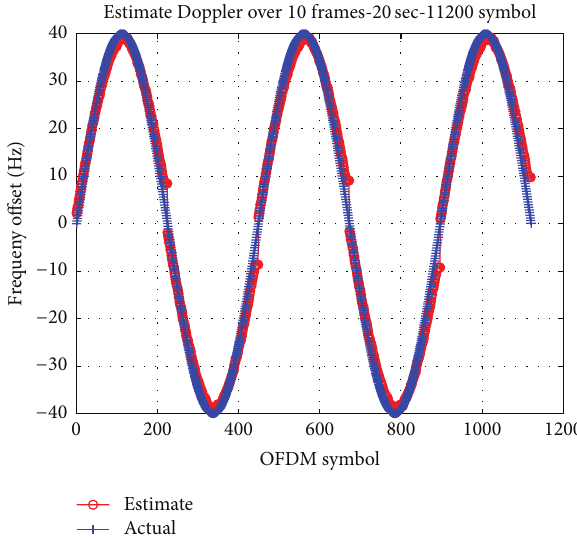
Figure 6: Simulation of Doppler estimation for both 16QAM and